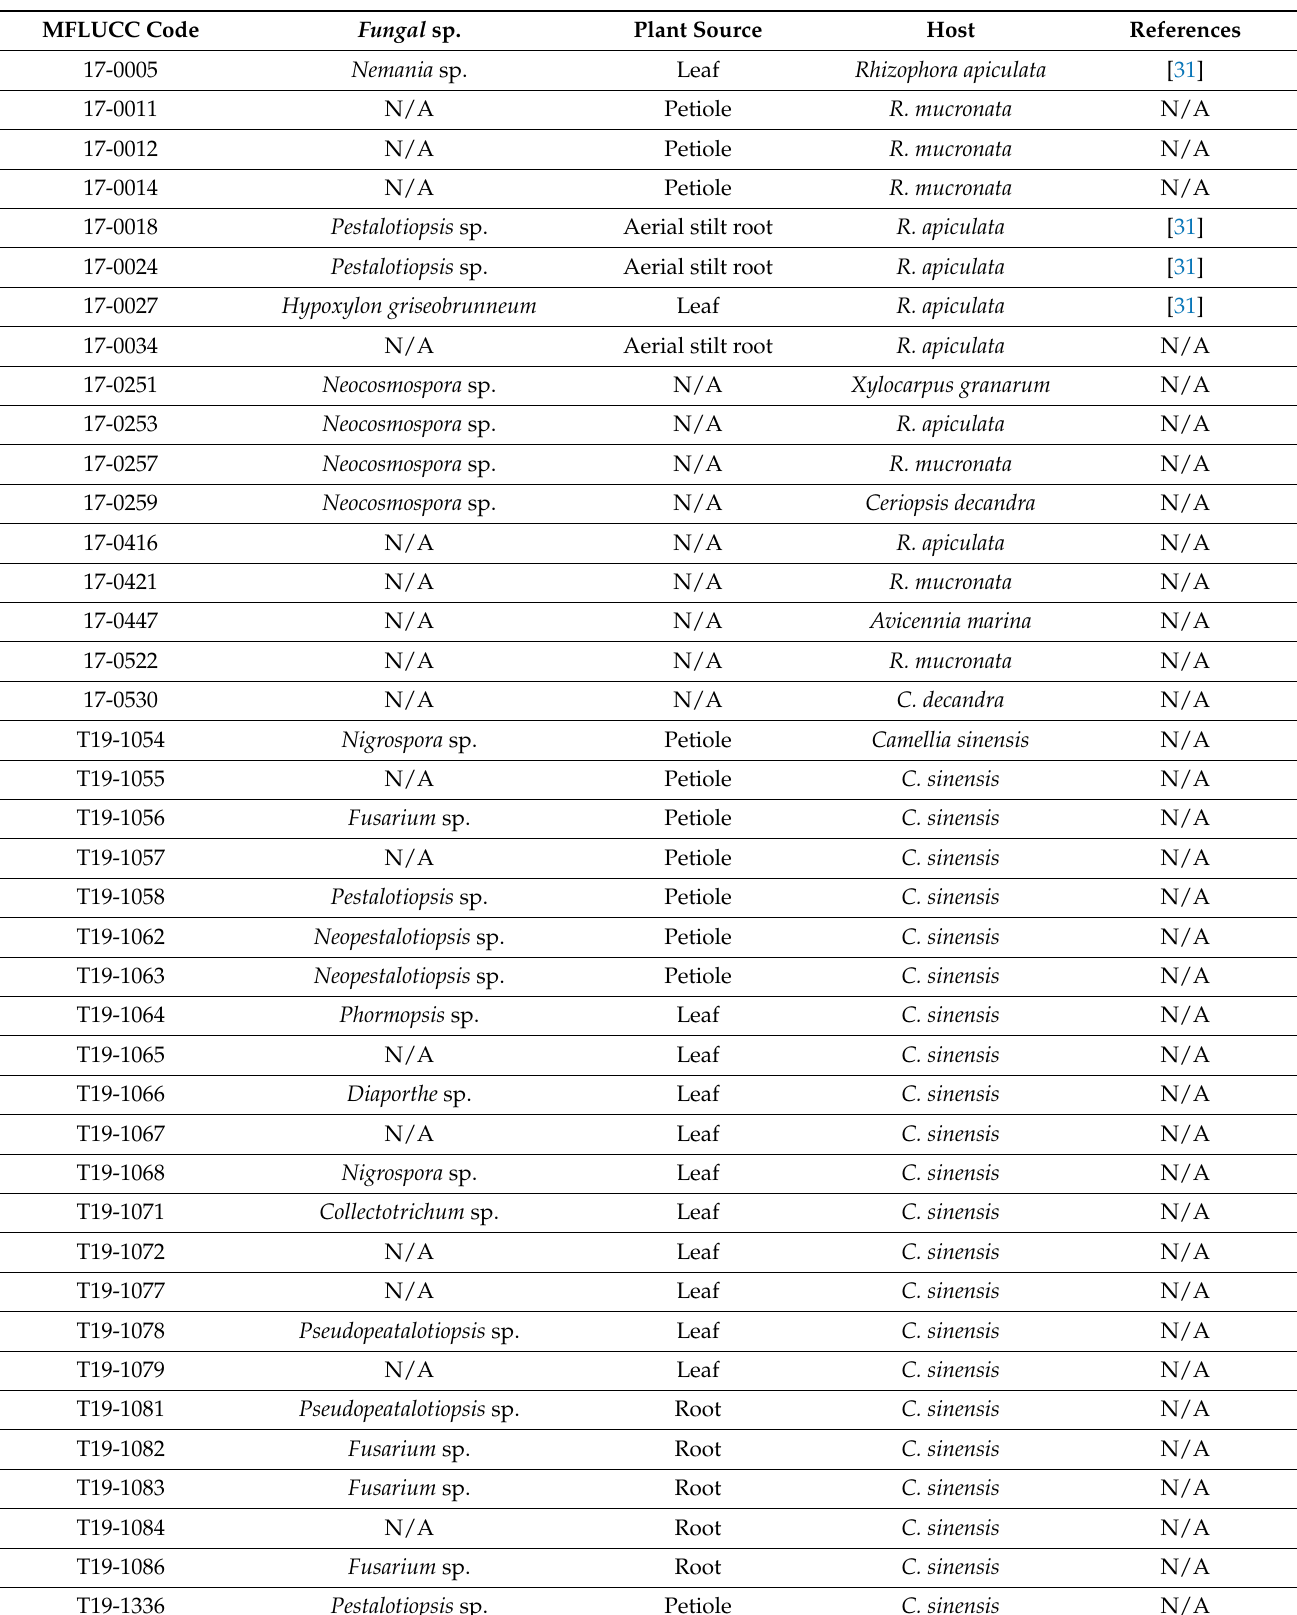
Table 1. List of fungal endophytes that used in this